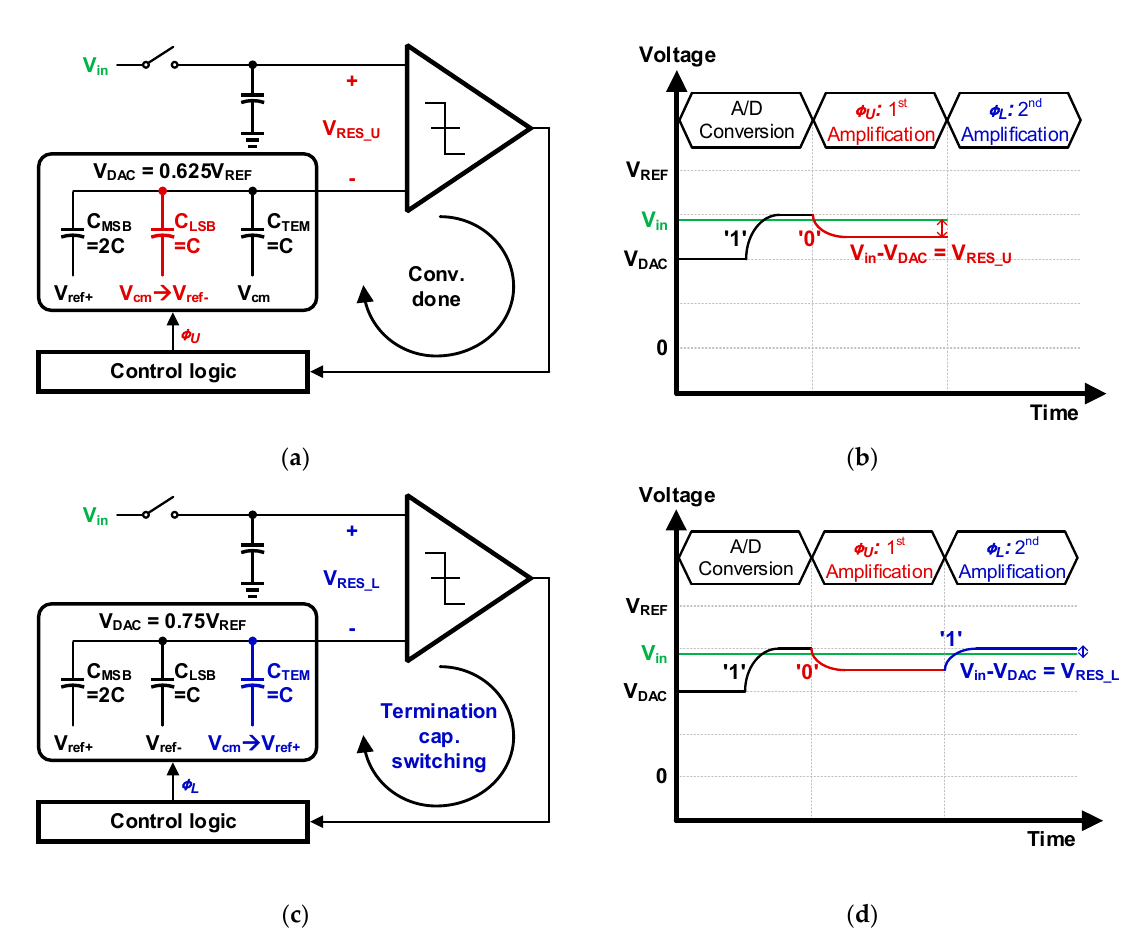
Figure 6. Conceptual operations from SAR ADC: ( a ) Block diagram; ( b ) Timing diagram; ( c ) Block diagram; ( d ) Timing diagram.